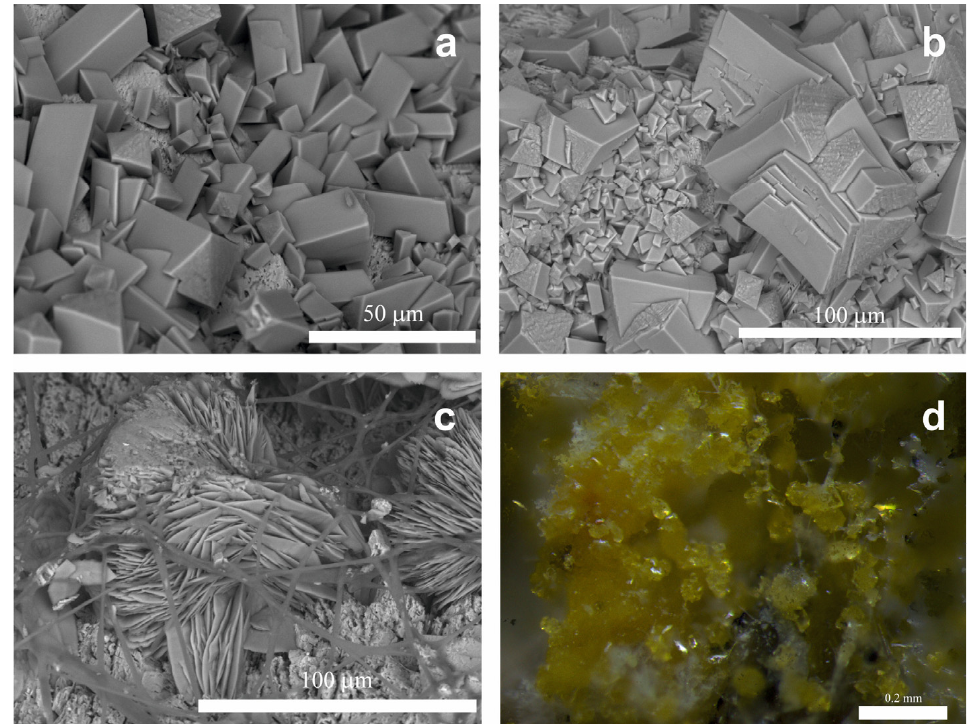
Figure 2. Formation of humboldtine crystals under the action of A. niger on the siderite surface: ( a )—SEM image on the 5th day, ( b )—SEM image on the 7th day, ( c )—SEM image on the 18th day, ( d )—under a light microscope on the 18th day.